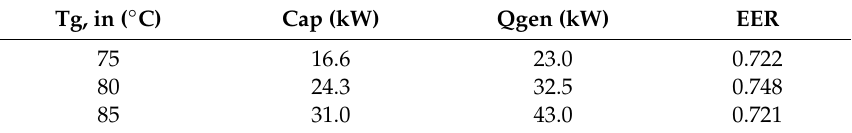
Table 3. EER for driving temperatures of 75, 80 and 85 °C under nominal conditions.